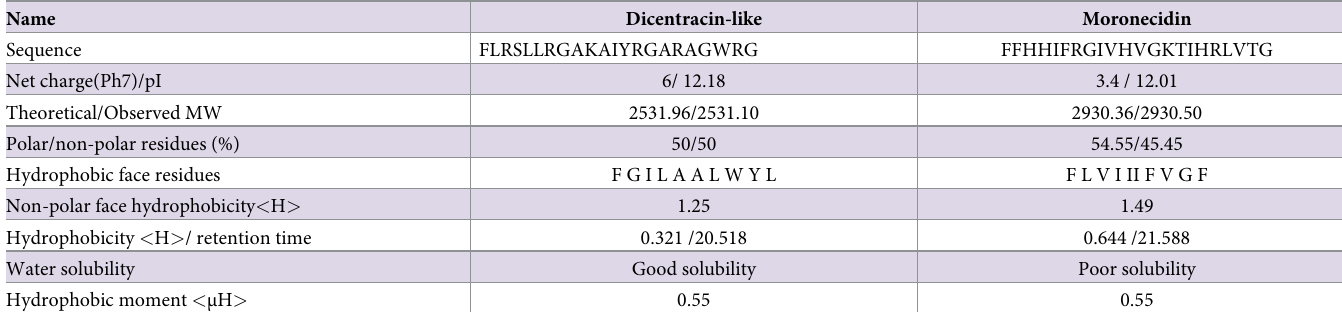
Table 1. Physicochemical properties of dicentracin-like and moronecidin.